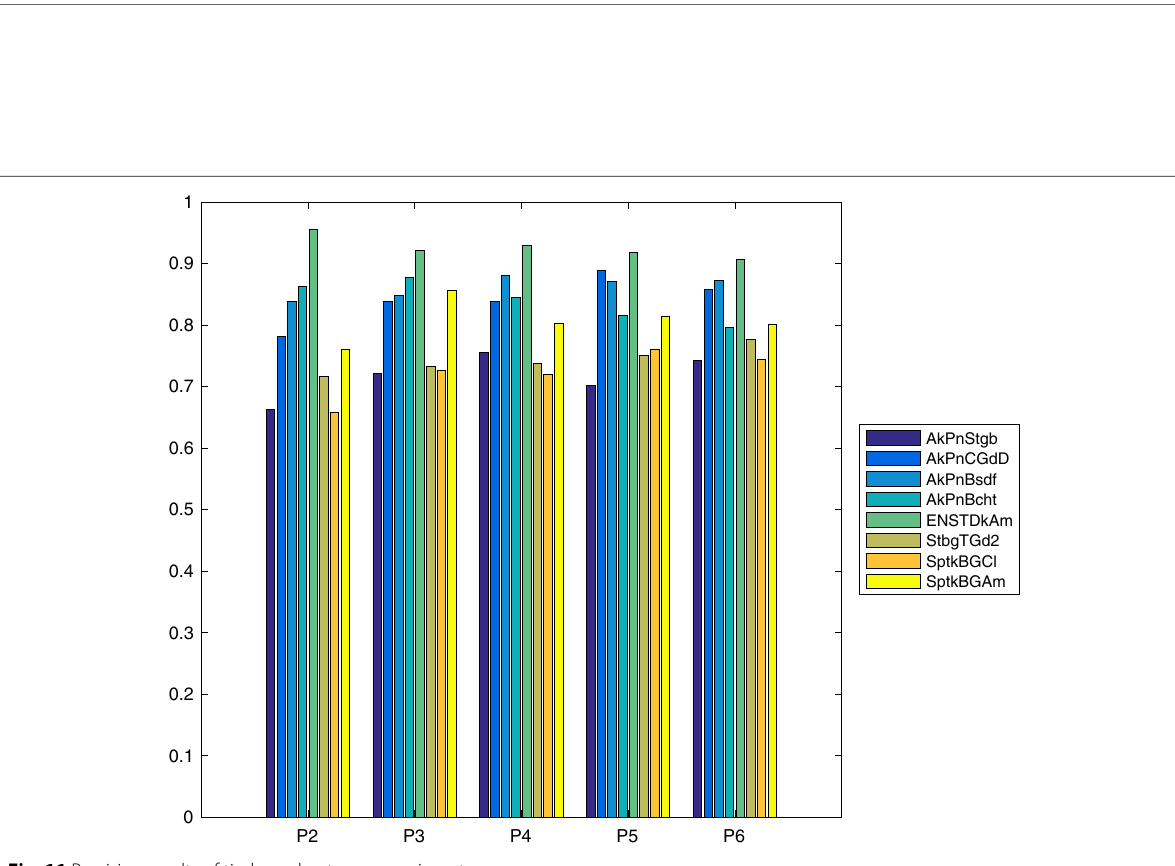
Fig. 11 Precision results of timbre robustness